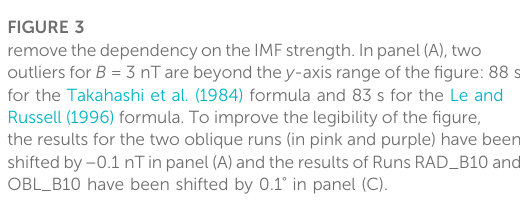
FIGURE 3 removethedependencyontheIMFstrength.Inpanel(A),two outliers for B = 3 nT are beyond the y -axis range of the fi gure: 88 s for the Takahashi et al. (1984) formula and 83 s for the Le and Russell (1996) formula. To improve the legibility of the fi gure, the results for the two oblique runs (in pink and purple) have